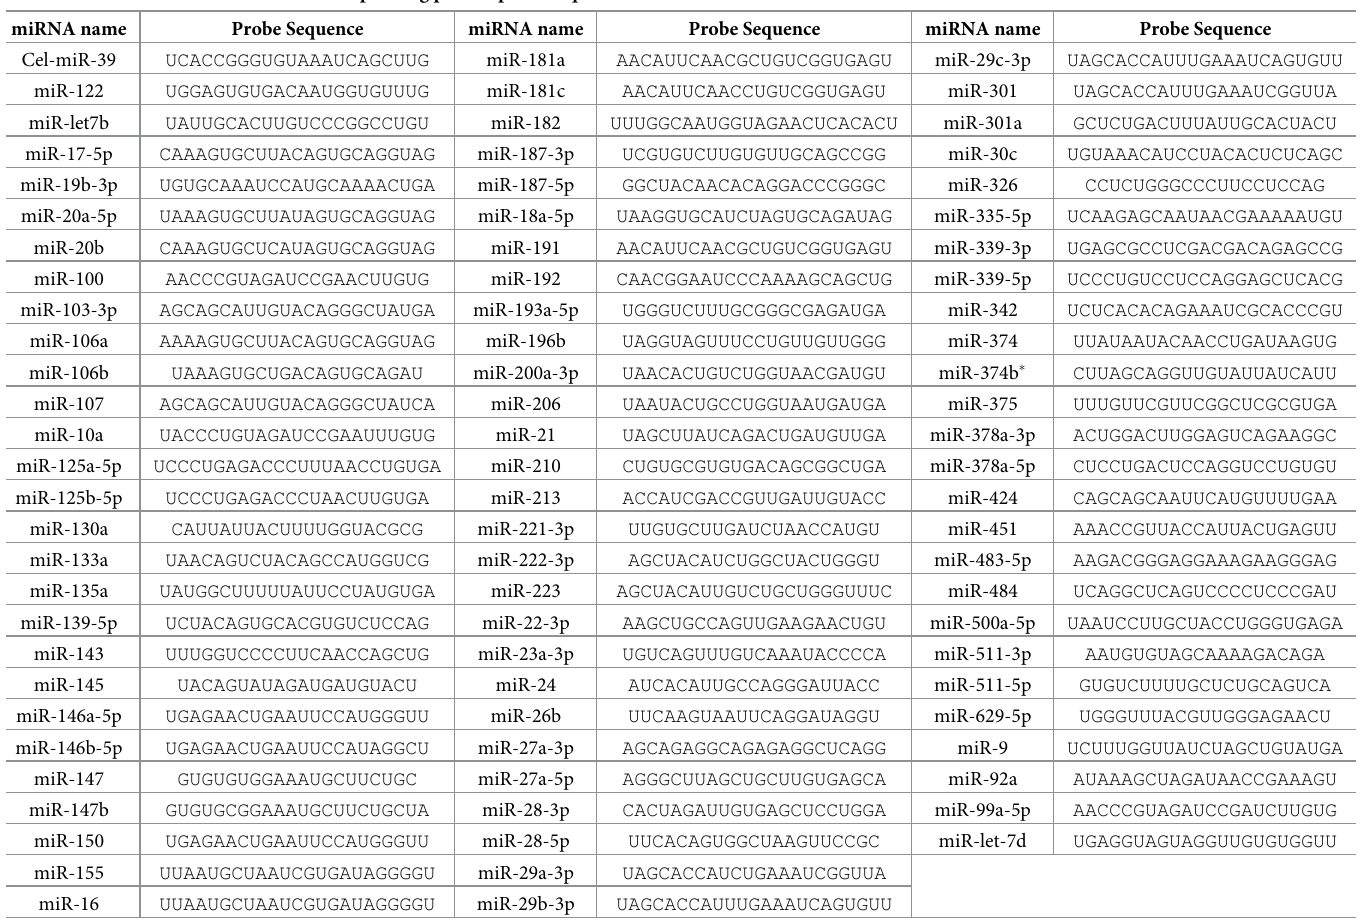
Table 1. Panel of miRNAs and their corresponding primer/probe